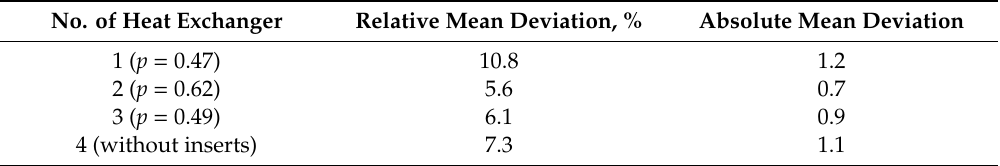
Table 2. Mean relative and absolute deviations of the outlet water temperature calculated theoretically and obtained